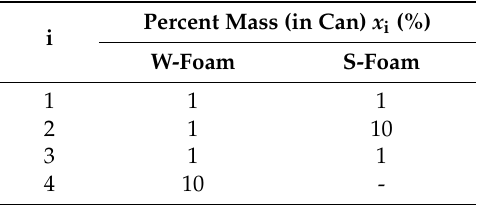
Table 9. The extreme gas assumed for